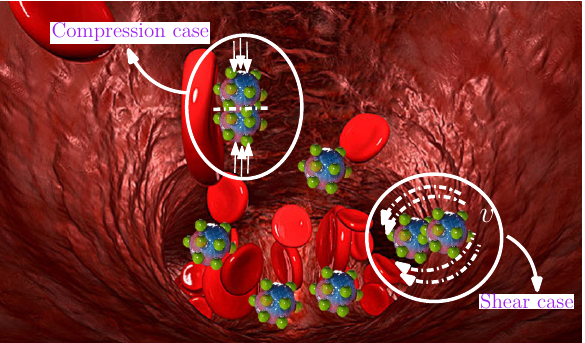
Figure 7. Schematic diagram of drug delivery in blood vessels